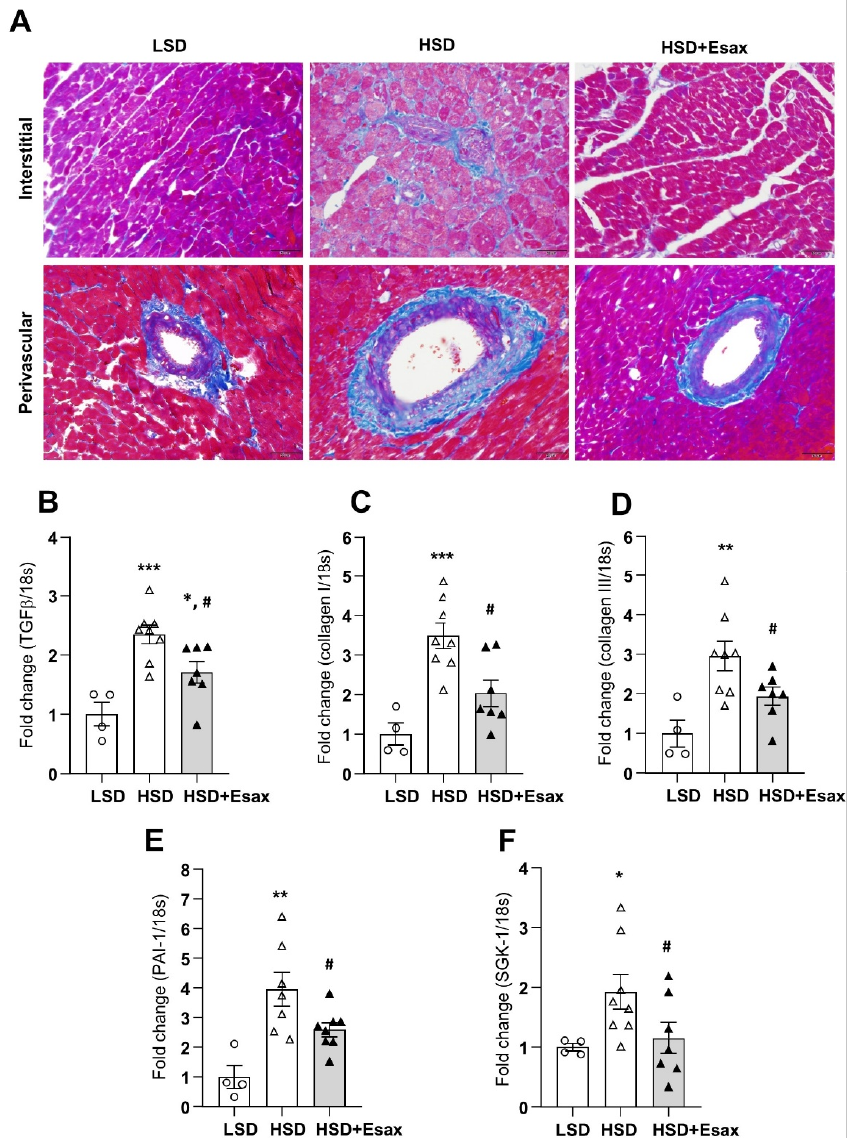
Figure 3. Esaxerenone treatment improves cardiac fibrosis in HSD-fed DSS rats. ( A ) Representative Azan staining in interstitial and perivascular regions of LV tissues, magnification 200 × , scale bar: 50 µ m. Obvious increase in fibrosis in the HSD-fed rats, which was attenuated in esaxerenone treatment group. The mRNA expression of cardiac fibrotic markers: ( B ) transforming growth factor (TGF)- β ; ( C ) collagen type I; ( D ) collagen type III; ( E ) plasminogen activator inhibitor (PAI)-1; and ( F ) serum and glucocorticoid-regulated kinase (SGK)-1 in the LV tissue obtained from the LSD, HSD, and HSD + Esax treatment groups. * p < 0.05, ** p < 0.01, *** p < 0.001 vs. LSD; # p < 0.05 vs.